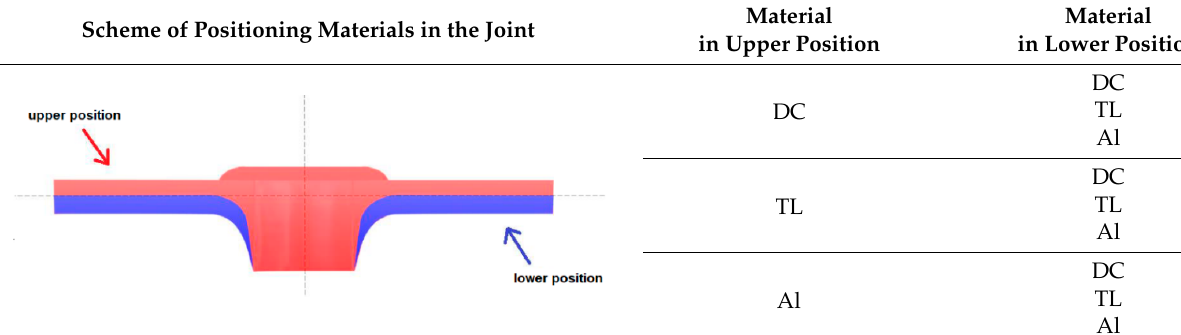
Table 4. Matrix of created joints.